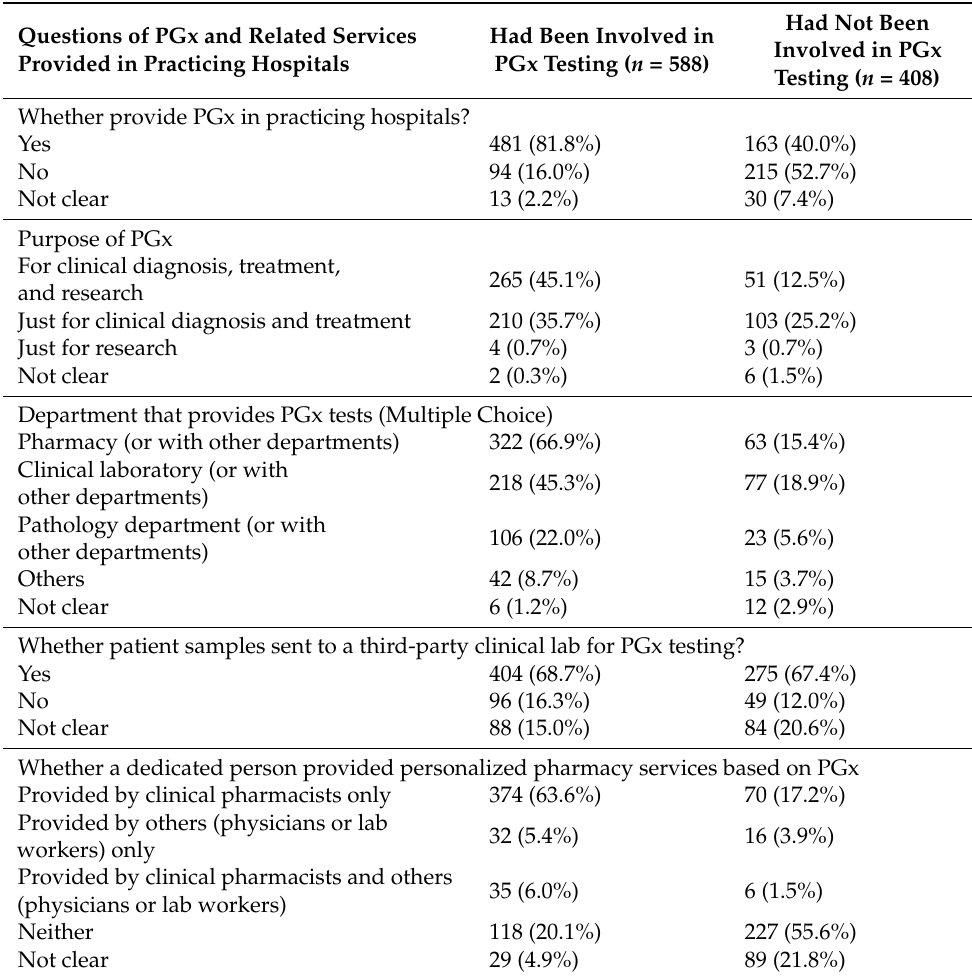
Table 2. The implementation of pharmacogenomics tests in hospitals ( n =